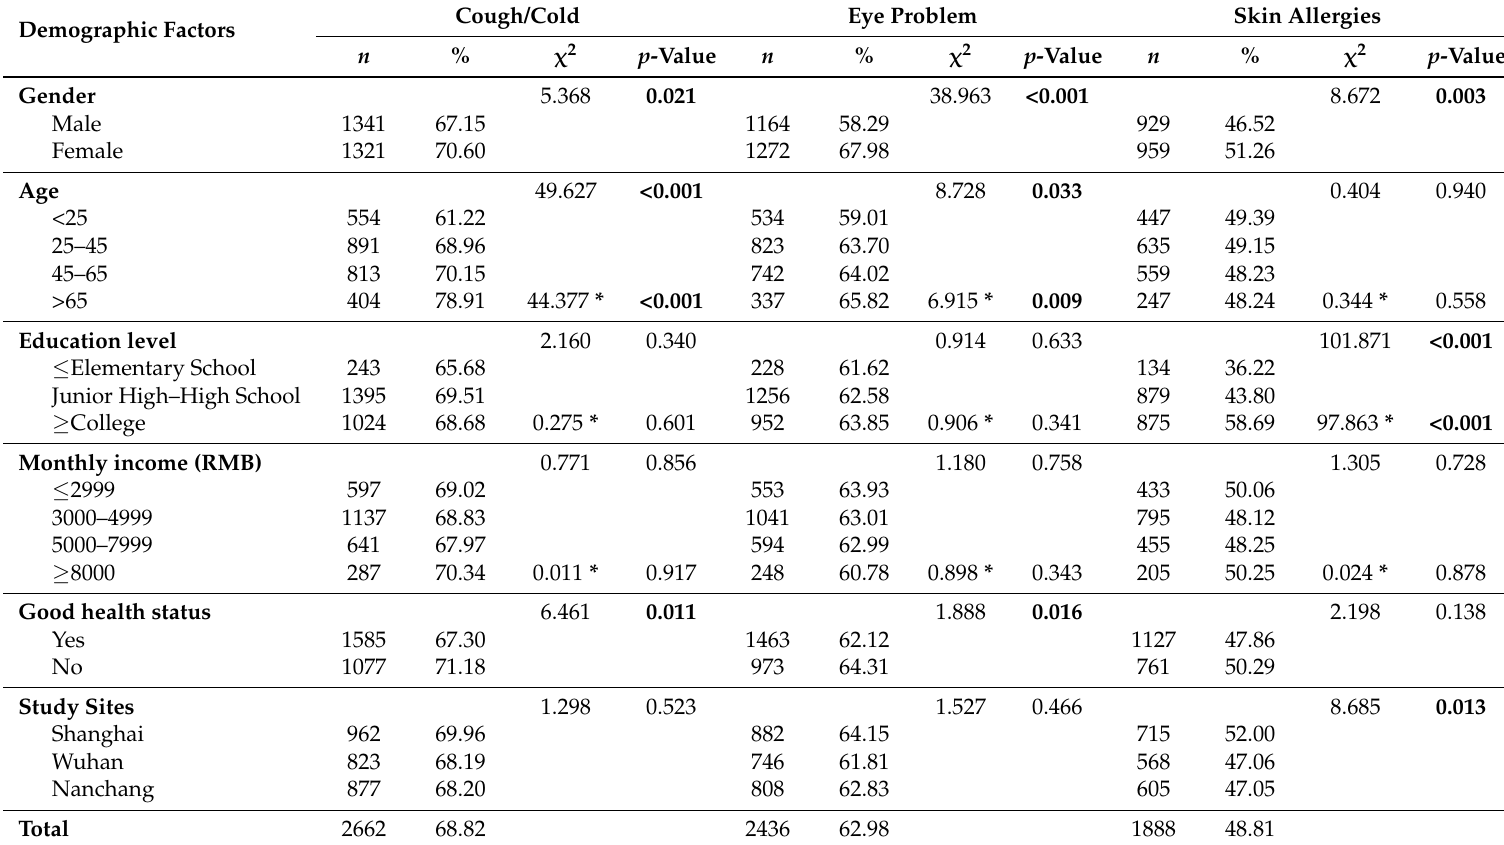
Table 7. Respondents’ beliefs about the three highest health risks due to urban air